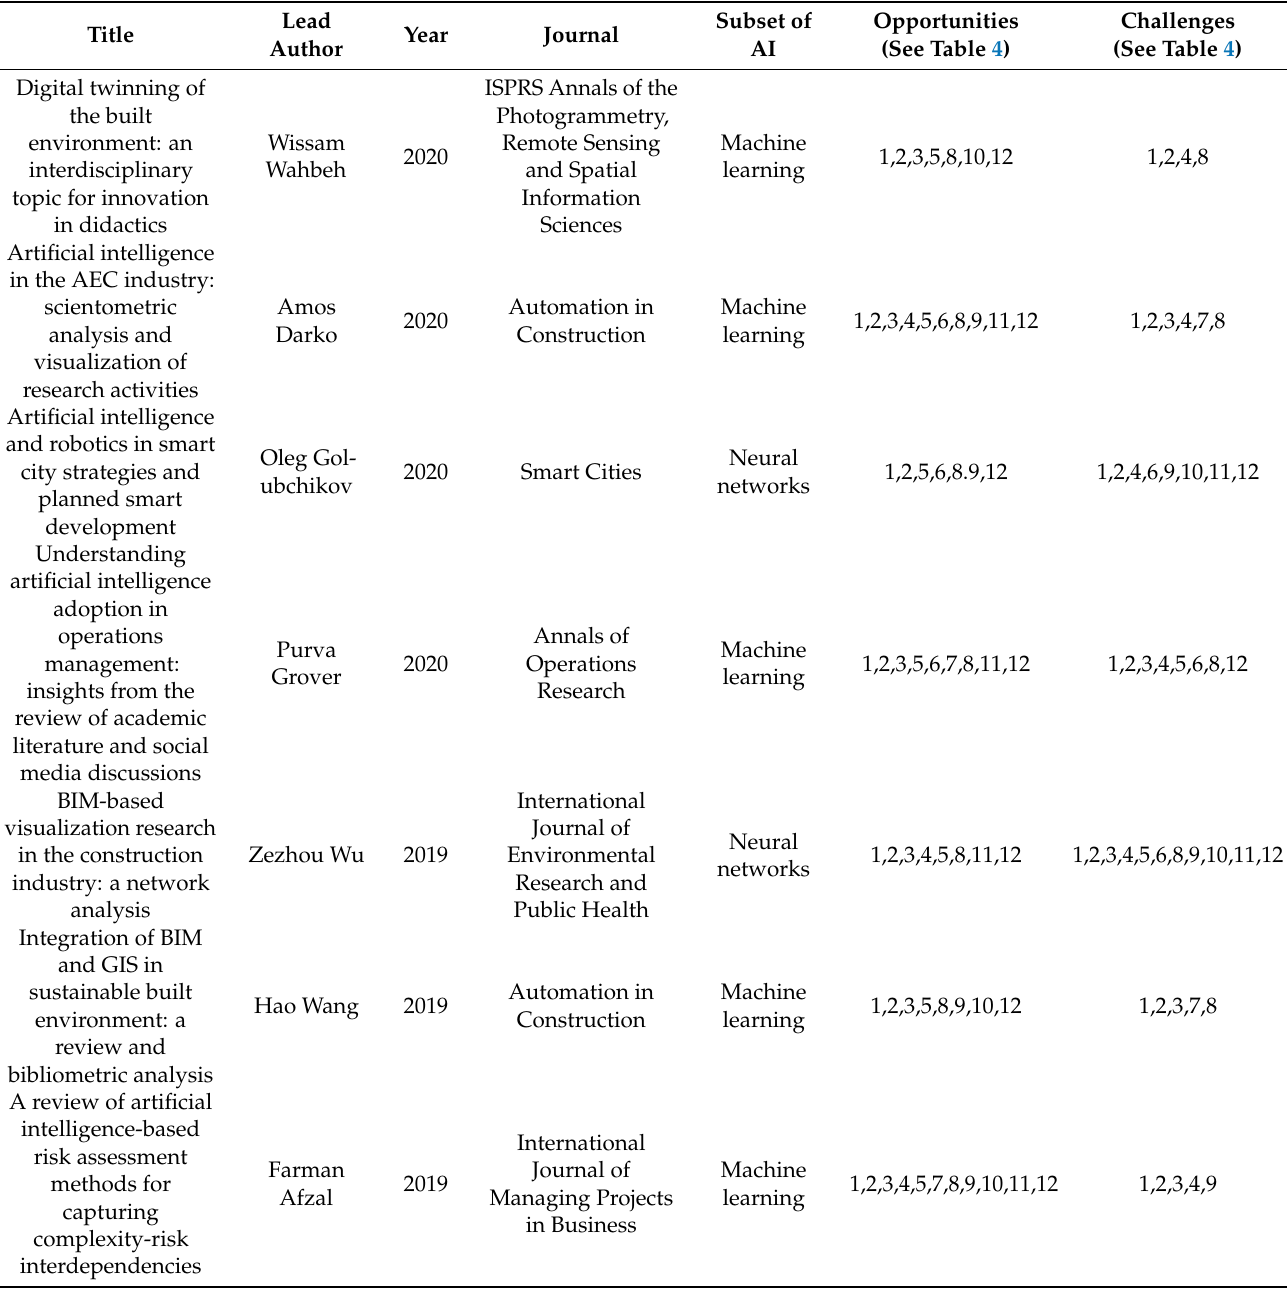
Table 6. Opportunities and challenges of adopting AI in the design